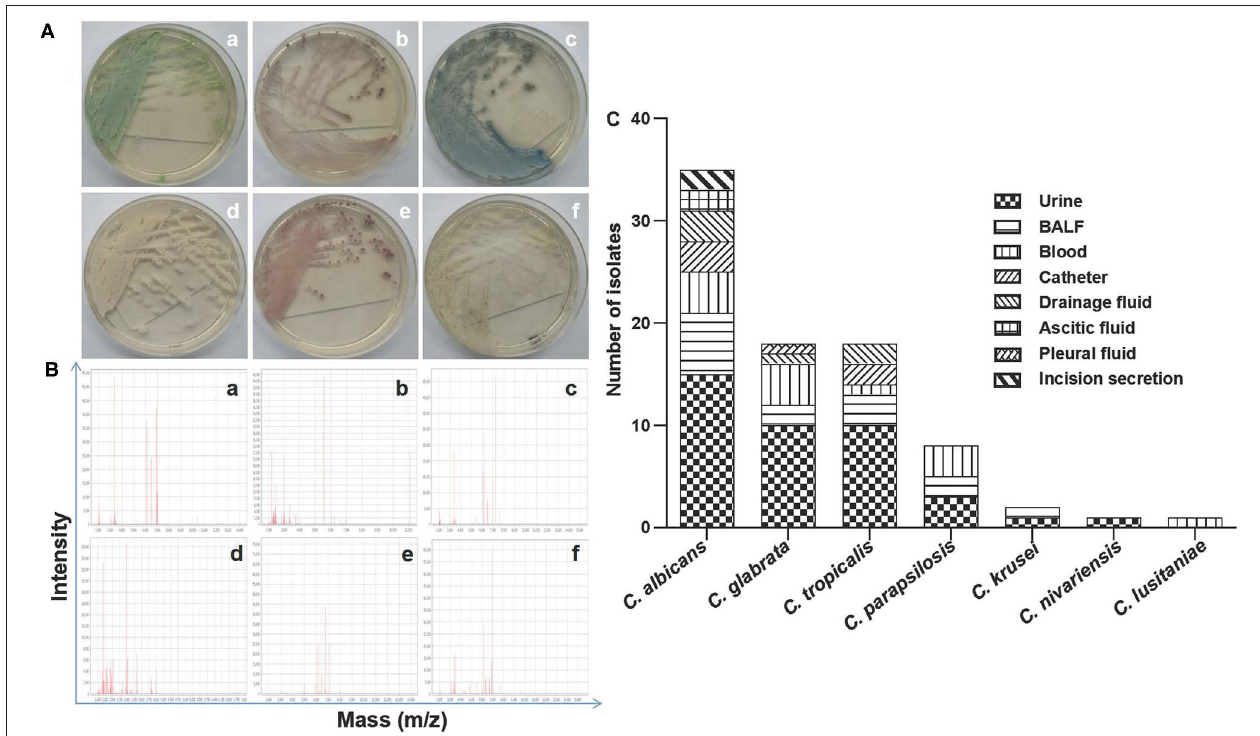
FIGURE 1 | (A) Representative culturing macroscopic results of Candida spp. (CHROMagar Candida chromogenic agar medium and/or Sabouraud Dextrose agar medium). (a–f) C. albicans , C. glabrata , C. tropicalis , C. parapsilosis , C. krusei , and C. lusitaniae . (B) Representative identification information of Candida spp. by MALDI-TOF MS. (a–f) C. albicans , C. glabrata , C. tropicalis , C. parapsilosis , C. krusei , and C. lusitaniae . (C) The species distribution and characteristics of specimen sources as indicated from the 83 isolates in the present study. BALF, bronchoalveolar lavage